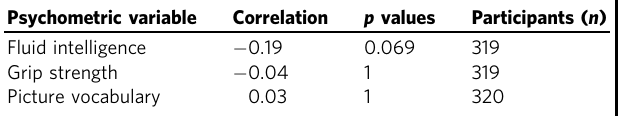
Table 3 Behavioural prediction results using discriminatory edges for model construction.